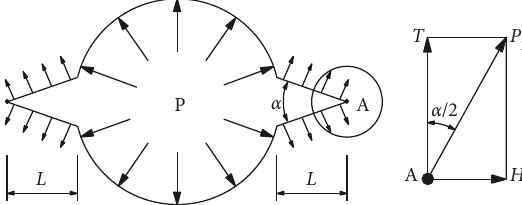
Figure 8: Load distribution on hole wall of notch